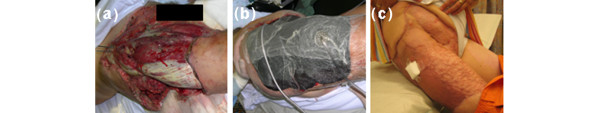
Wound management via vacuum-assisted closure therapy. (a) Large-scale tissue damage at hip and upper lower extremity. (b) Vacuum-assisted closure therapy. (c) Successful skin grafting.